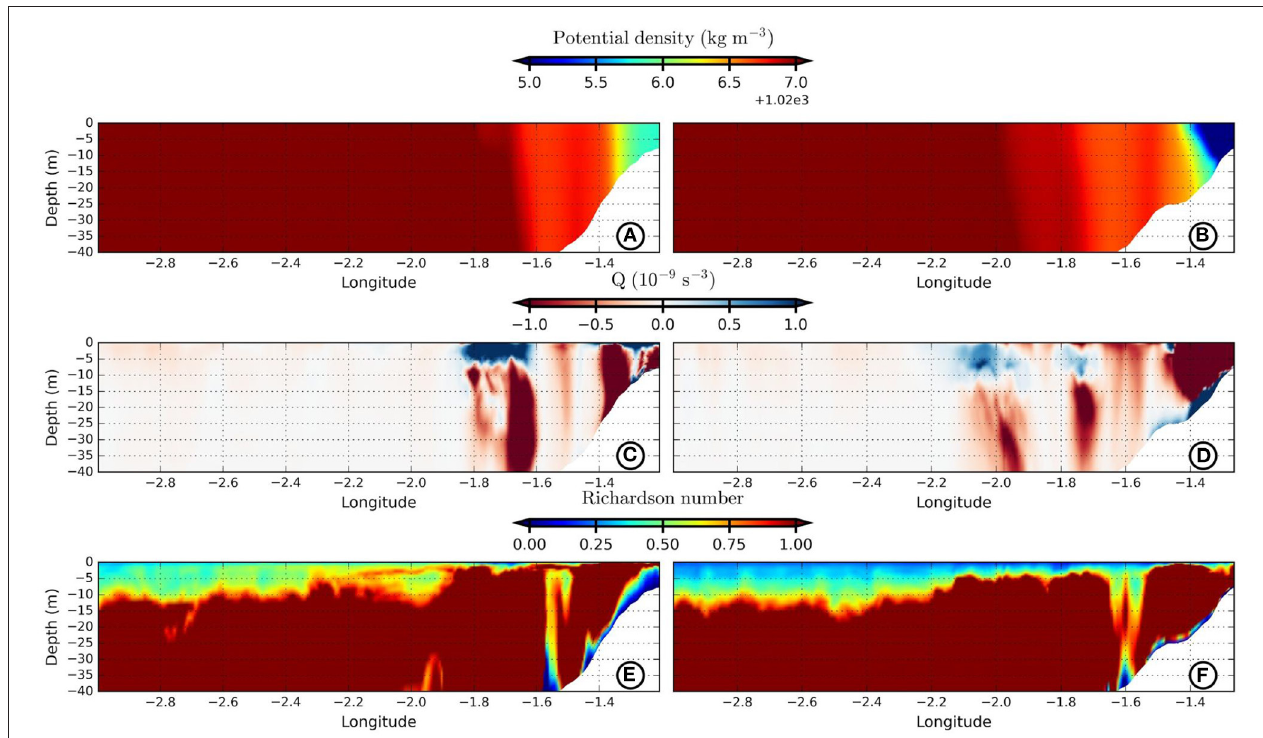
FIGURE 9 | Snapshot (12/03/2008 at midday) of: the Potential density in section 1 (A) and in section 2 (B) (cf. Figure 7 ), the PV in section 1 (C) and in section 2 (D) and the Richardson number in section 1 (E) and in section 2 (F)